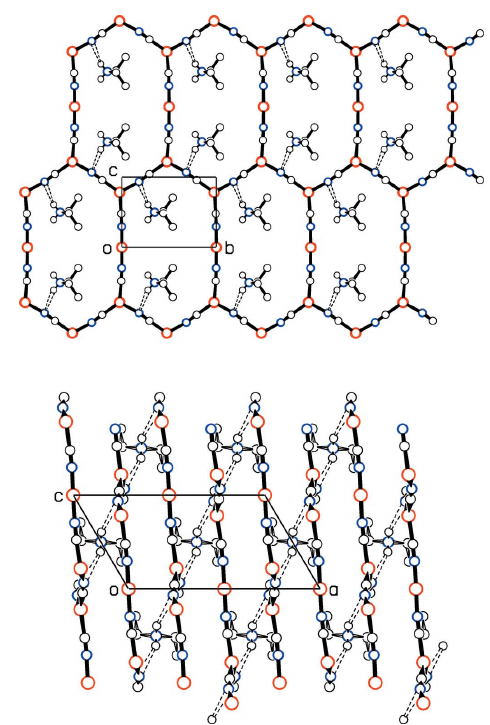
Figure 2 Top: View along the a axis of one sheet. Hydrogen bonds from cations above and below the sheet are shown. Bottom: Projection down the b axis, showing the sheets stacked perpendicular to the a axis, and the hydrogen bonds linking the sheets together. (Scale is slightly larger than in the top diagram.) The chains of hydrogen bonds along the [102] direction are evident. Cu atoms are colored red, N atoms blue, and C and NH atoms black. H atoms of the C 2H gropu are not shown, and only one 5 orientation for each of the disordered CN groups is drawn.